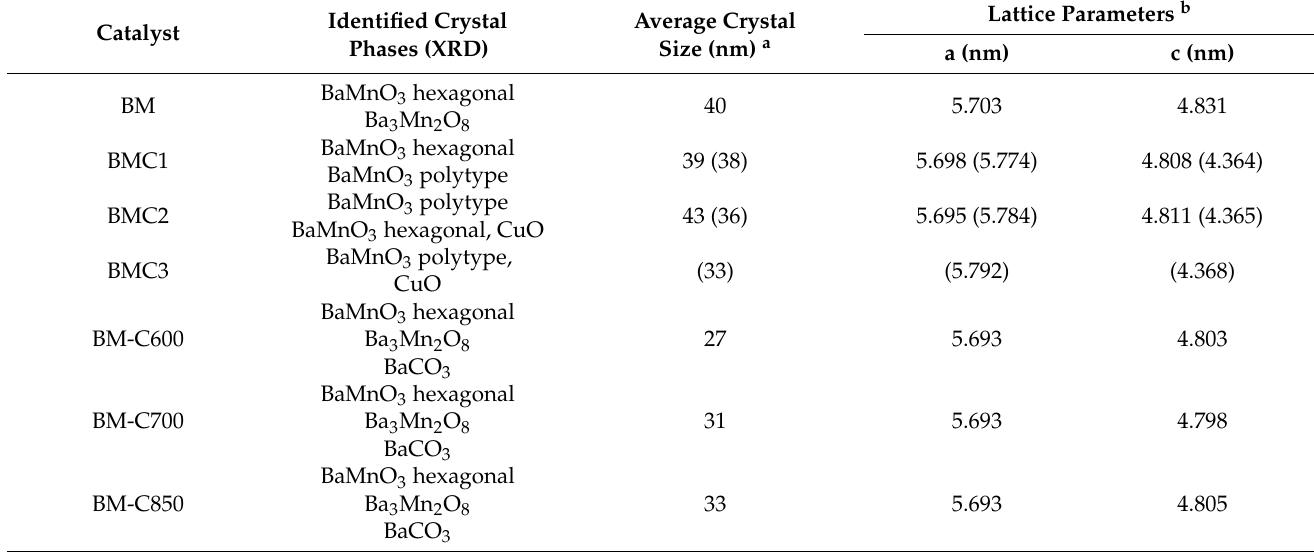
Table 2. Crystal phase, average crystal size and lattice parameters of the